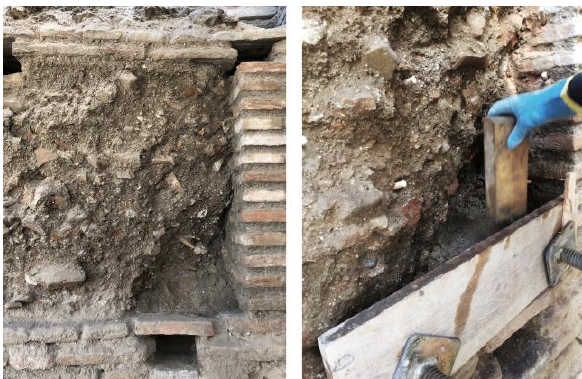
Figure 10. Manual ramming of the mass with the use of a rammer, and taping of the top surface with a